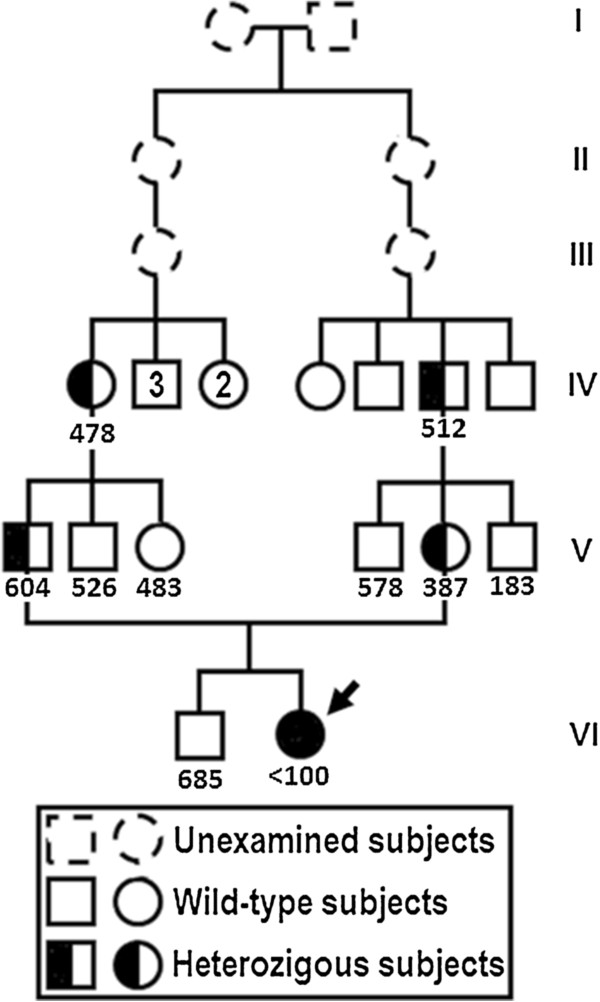
Pedigree of the patient. Cobalamin levels are indicated (pg/ml; n.v. 211-911). Heterozygous subjects have normal levels of cobalamin.